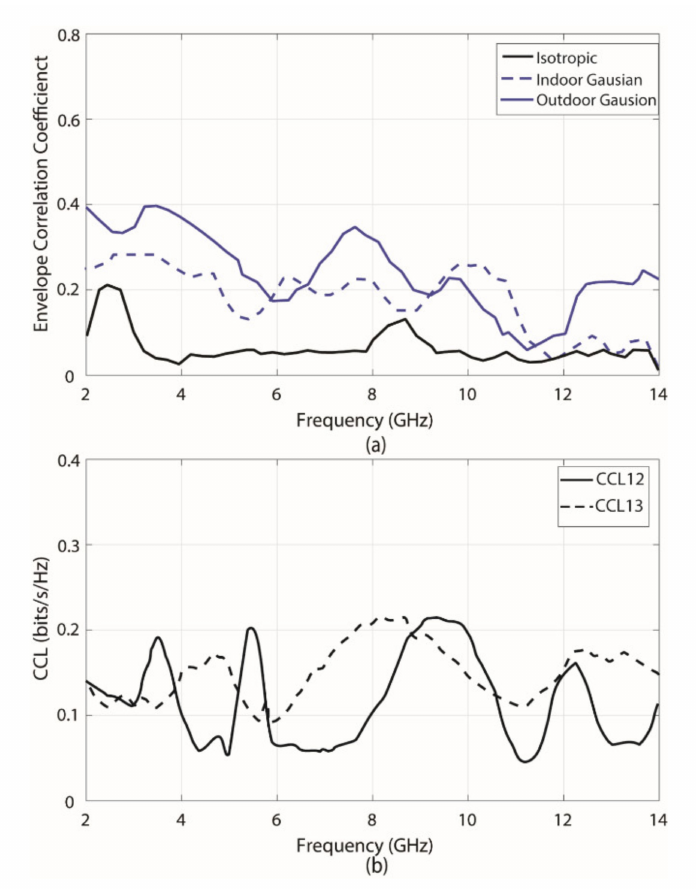
Figure 11. ( a ) Simulated ECC of antenna array computed from far-field radiation patterns for isotropic, indoor and outdoor environments. ( b ) CCL plot over the entire spectrum.